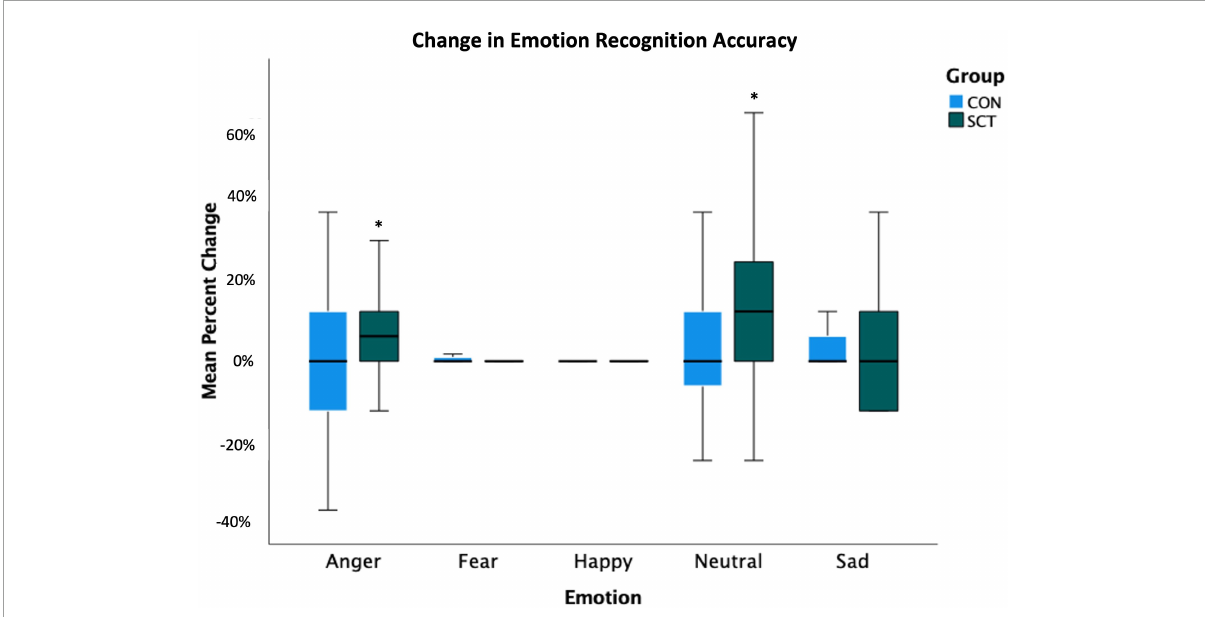
FIGURE1 Change in emotion recognition accuracy (calculated as percent correct) following the intervention is shown. Pre-intervention accuracy percentages were subtracted from post-intervention accuracy percentages to yield the percent change values. ∗ Indicates significant change from pre- to post-intervention ( p < 0.05).